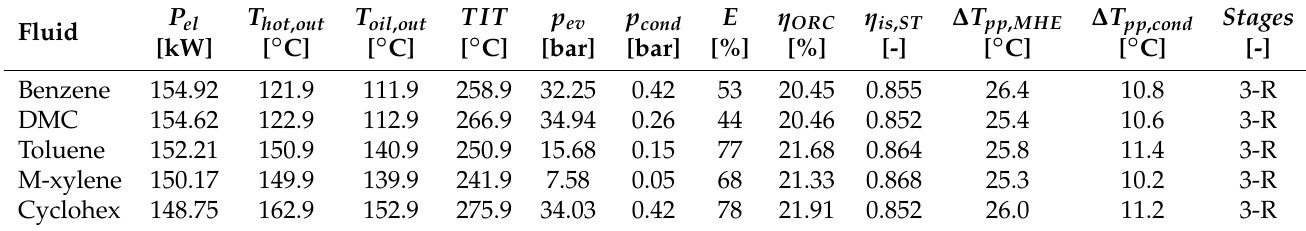
Table A9. Most promising fluids in the case of adopting an ORC and an oil loop.